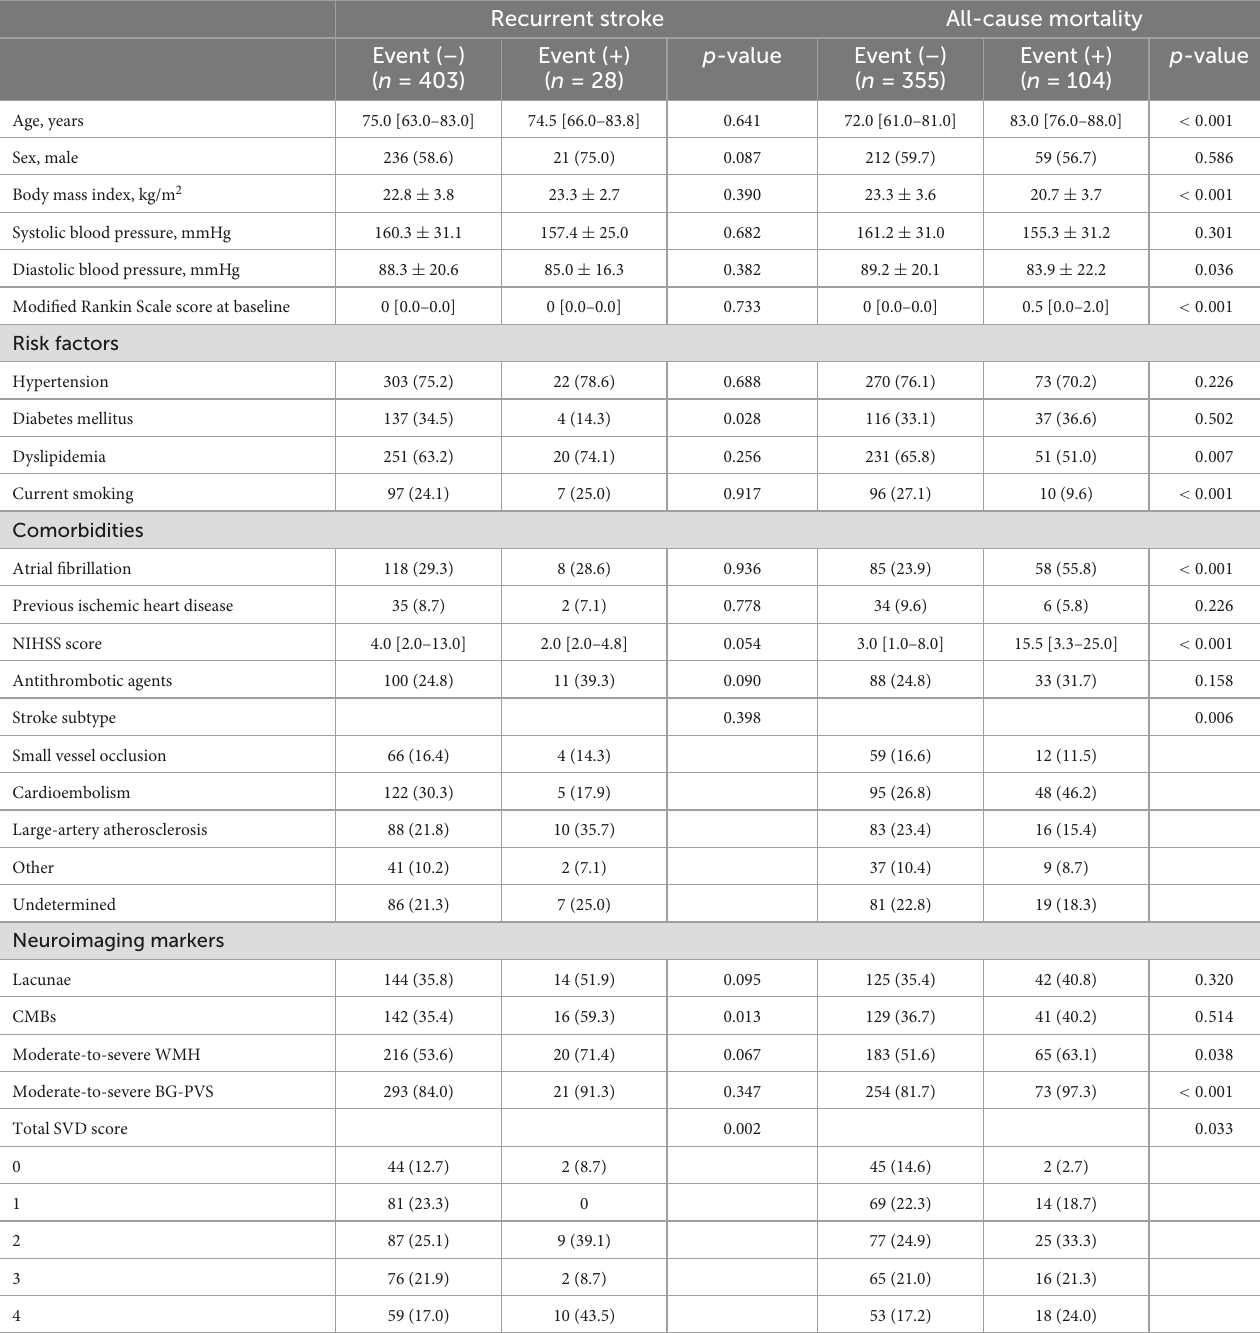
TABLE 3 Univariate analysis for prognosis in first-ever ischemic stroke patients. Recurrent stroke All-cause